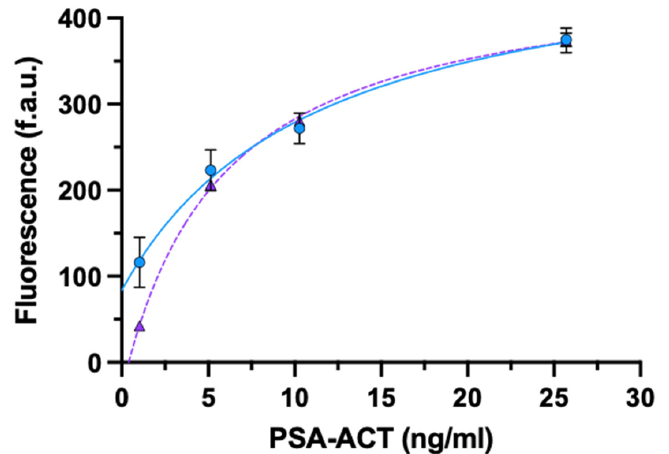
Figure 3. ELISA for the detection of PSA-ACT using oriented rIgG (circle) or non-oriented whole-IgG (triangle). Data are presented as mean ± SD ( n = 4). Fitting equations: rIgG (solid line) y = (83.74 + 44.24x)/(1 + 0.09x); IgG (dashed line) y = ( − 32.50 + 81.26x)/(1 + 0.18x). For the lowest concentration tested (1.03 ng/mL), rIgG showed 3-fold signal enhance- ment compared to whole IgG (mean ± SD: 116.01 ± 29.21; 42.61 ± 1.19,